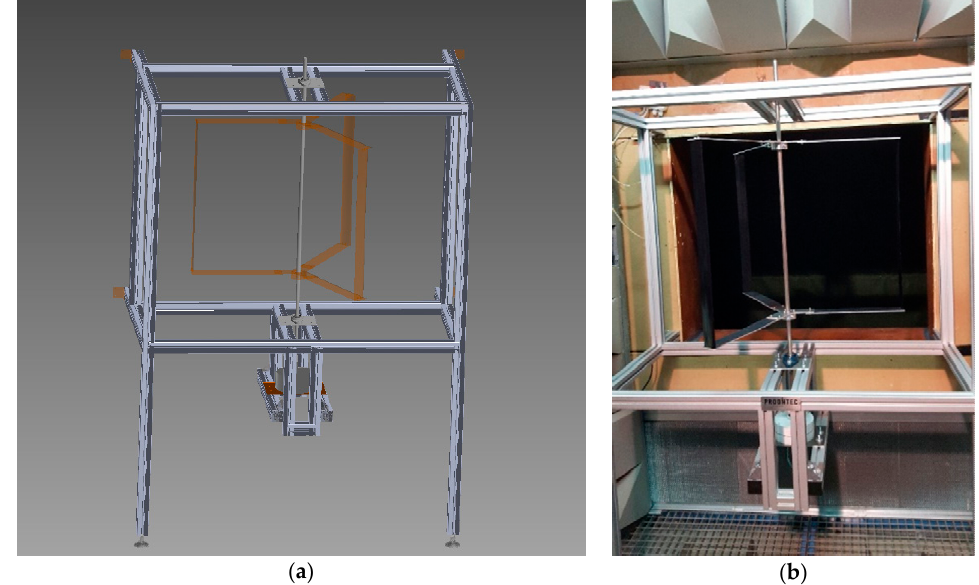
Figure 4. Final prototype design: ( a ) CAD view; ( b ) Assembly and placing into the wind